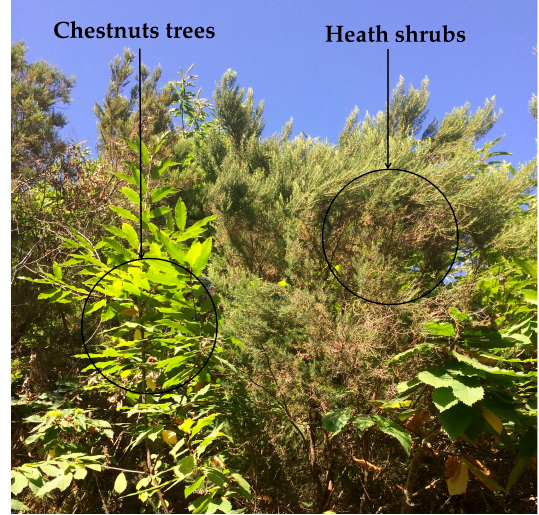
Figure 2. Chestnuts trees in the study area mixed with heath shrubs.